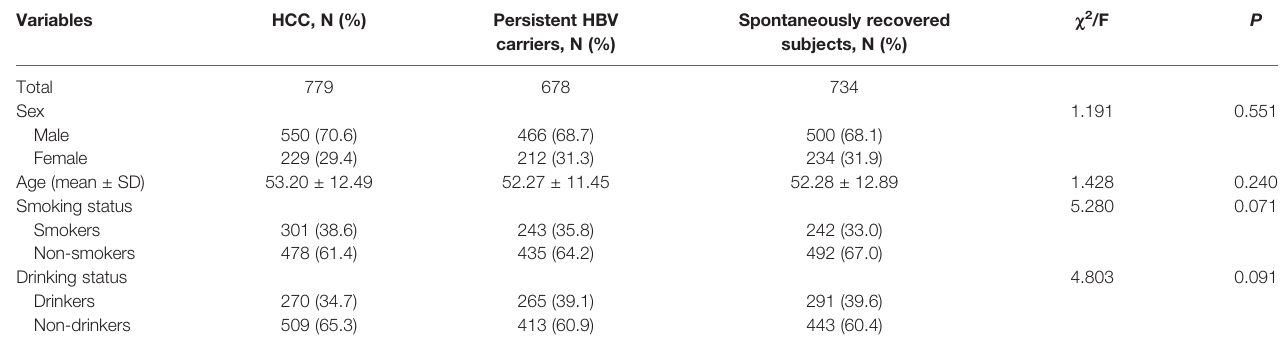
TABLE 1 | The characteristics of the included